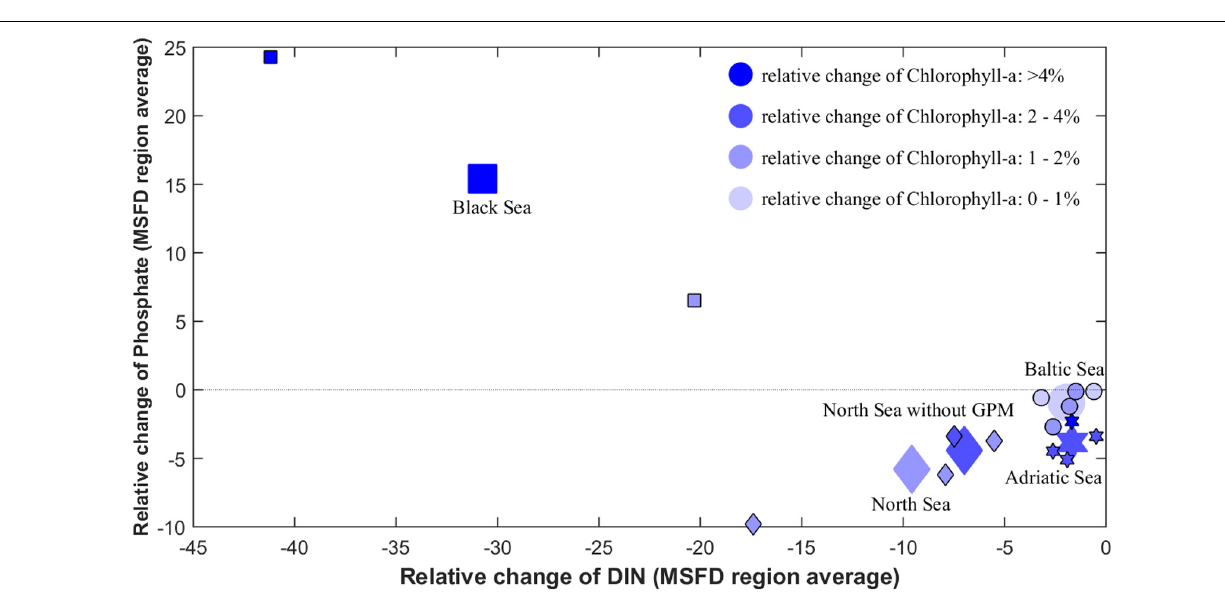
FIGURE 6 | Relative change of chlorophyll-a concentration per MSFD region (bluish colors refer to the change intensity of chlorophyll-a) as function of the relative changes of the dissolved nutrients DIN and phosphate from all the single models (ensemble means per region are highlighted by the enlarged